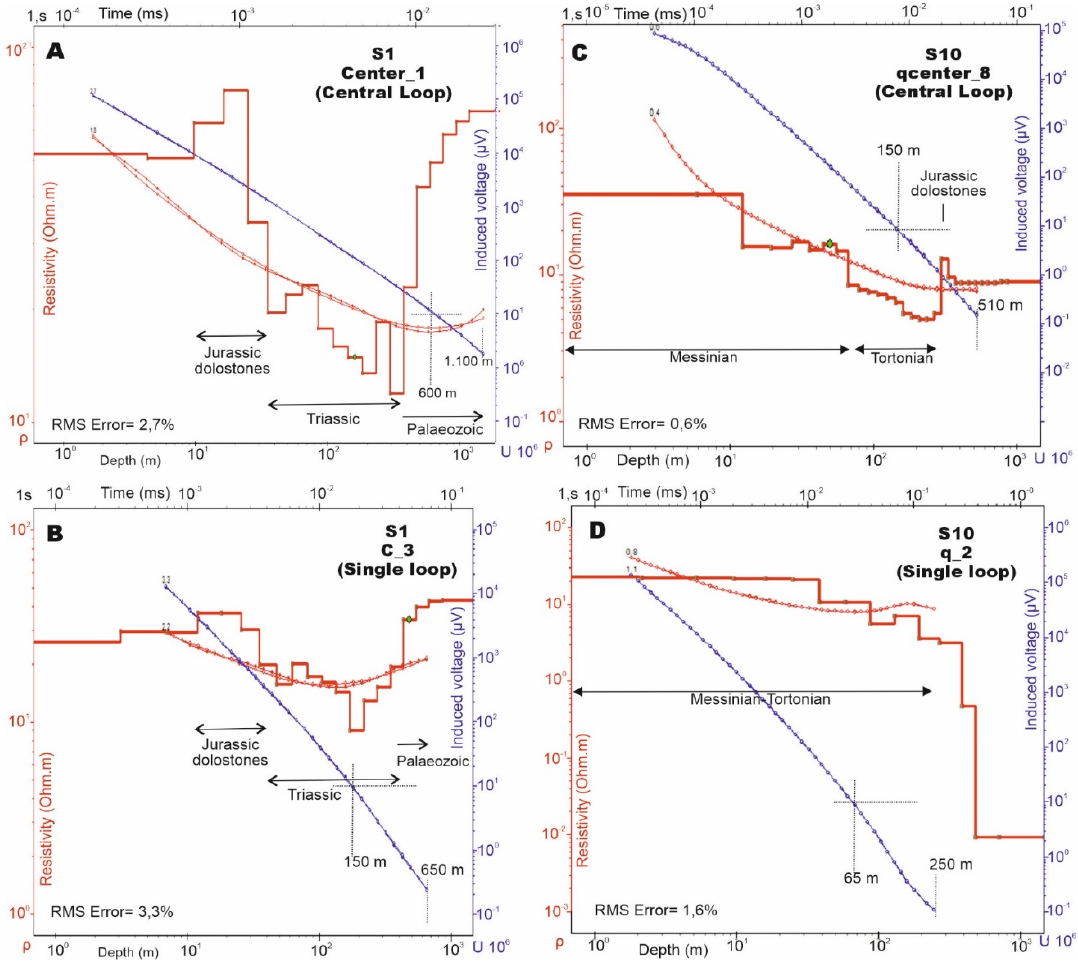
Figure 5. Induced voltage curves (blue line) and apparent resistivity (red line) as a function of time. For each of them, the fit between the field and the model (by the ZONDTEM1D software) lines is indicated. The interpretation after the inversion of the data is also included; red straight lines represent the resistivity as a function of the depth. In charts A and B, data collected at station S1 (see Figure 2) using two different devices are represented: central-loop ( A ) and single-loop ( B ). In charts ( C , D ), data collected at station S10 (see Figure 2) using central-loop ( C ) and single-loop ( D ) devices are also shown.